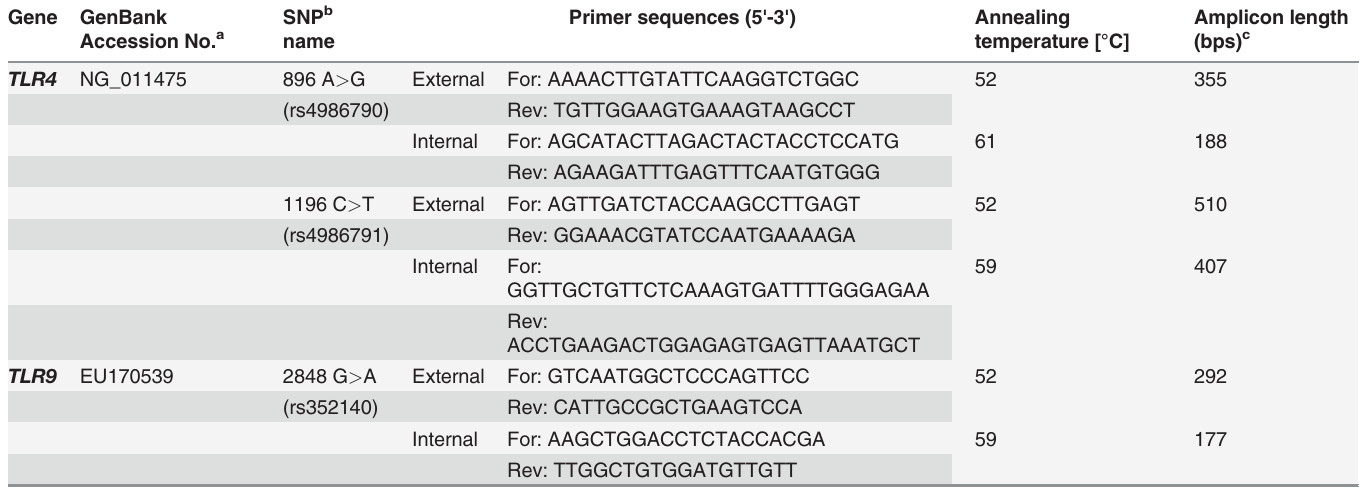
Table 1. Primer sequences, annealing temperatures and amplicon lengths, obtained in multiplex nested PCR assay for SNPs in the TLR4 and TLR9 genes. Gene GenBank Accession No.